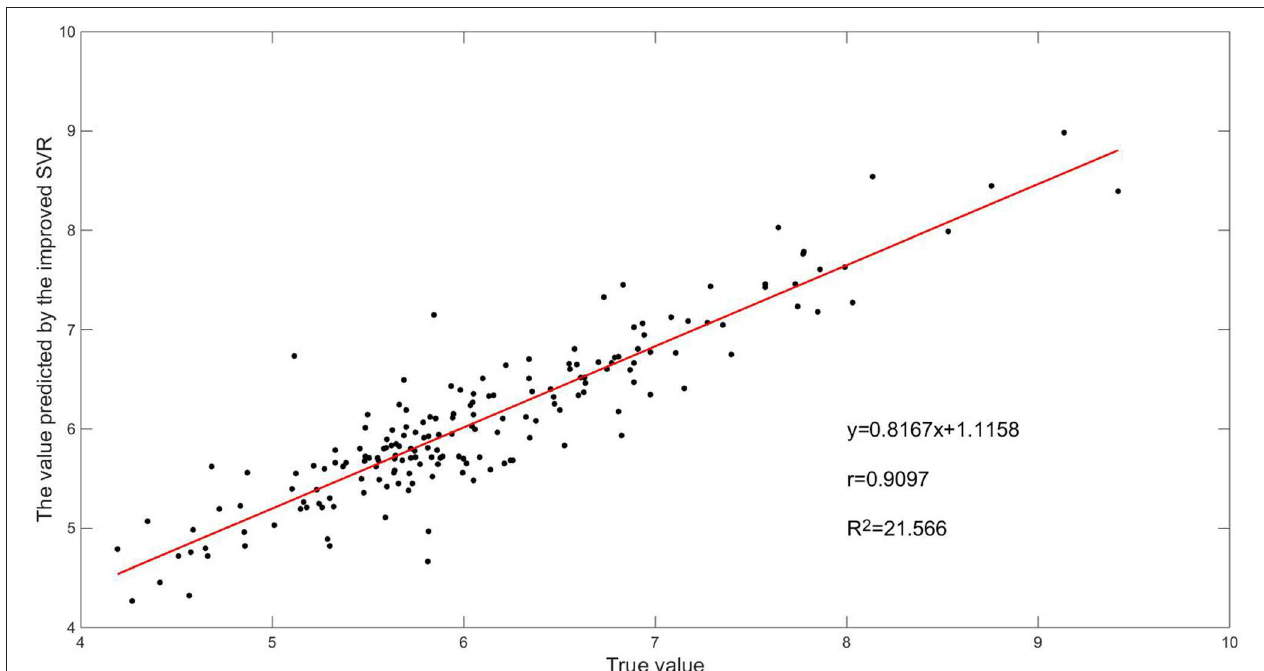
FIGURE 13 | Fitting graph for the result of improved SVR